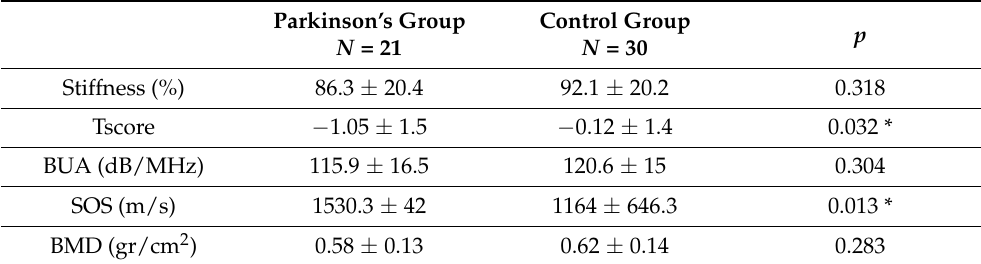
Table 2. Bone parameters related to bone quality between the group of patients with Parkinson’s disease (Parkinson’s group) and healthy people (control